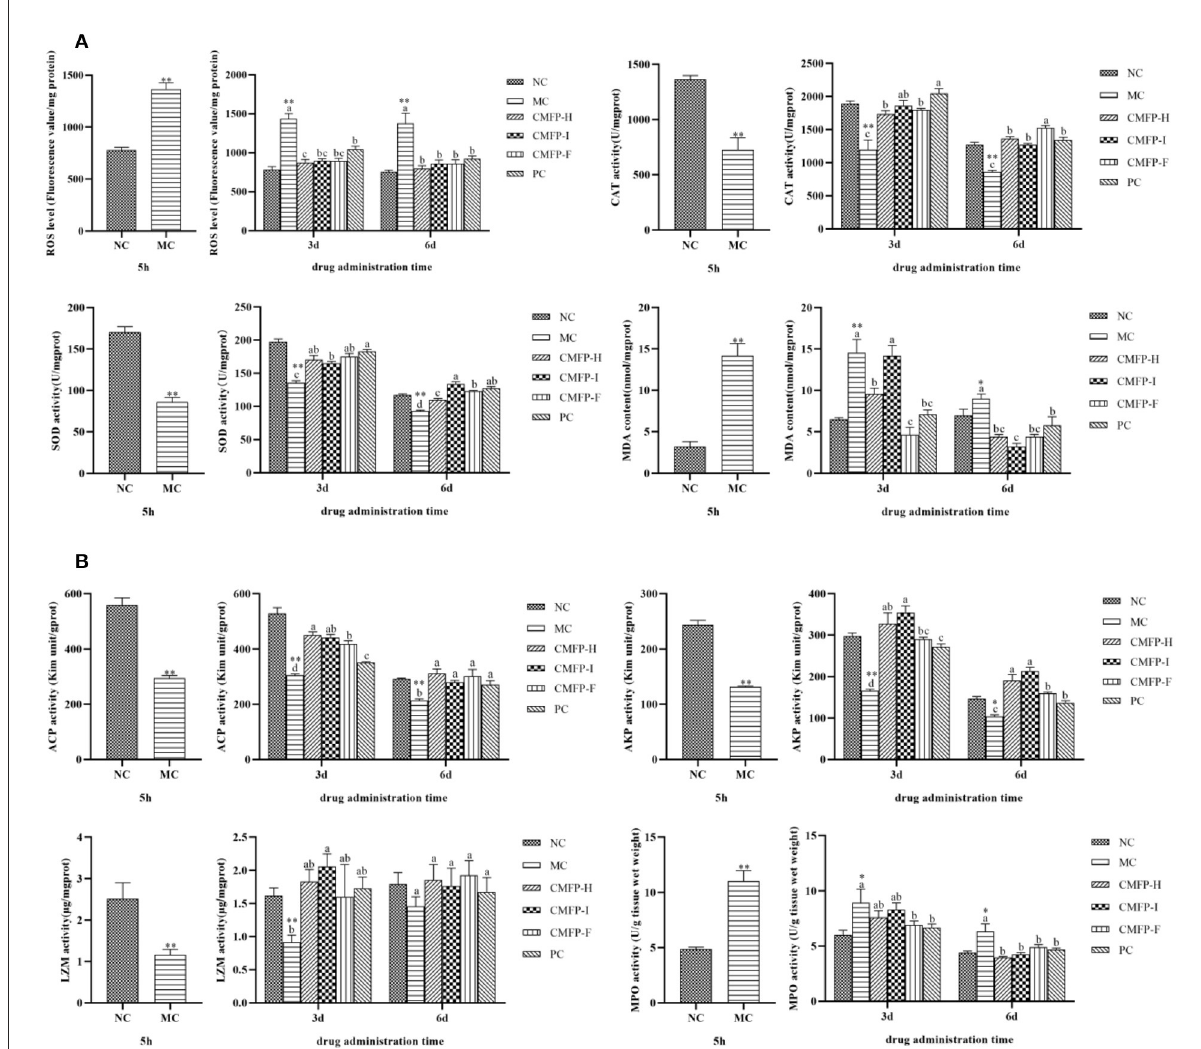
FIGURE4 Effects of CMFPs on the activities of antioxidant enzymes and immune-related enzymes in the intestine of zebrafish with inflammatory bowel disease at 5h, 3 d, and 6 d. (A) The ROS levels, SOD and CAT activities, and MDA content. (B) The ACP, AKP, LZM, and MPO activities. MC compared with NC, ** p < 0.01, * p < 0.05; CMFPs and PC groups compared with MC indicated significant differences between groups marked with different letters ( p < 0.05).